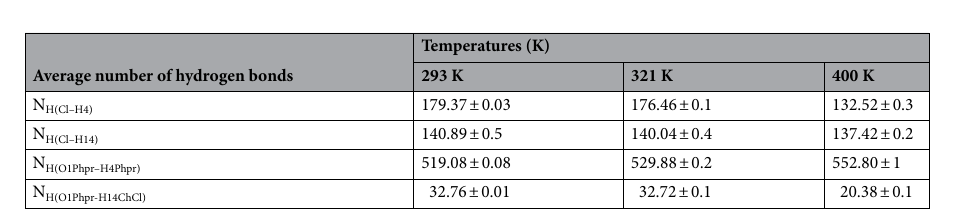
Table 2. The average value of the number of hydrogen bonds (N H(i−j) ) in DESs at 293, 321 and 400 K. N H(i−j) refers to the number of H-bond formed between molecule i and j.